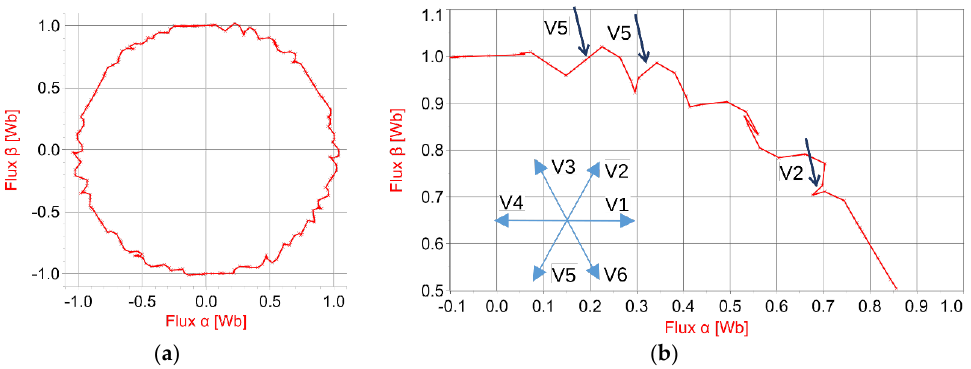
Figure 12. ( a ) The measured flux vector tip trajectory in αβ plane in one flux vector turn at the model predictive control (MPC) strategy; ( b ) The detail of the trajectory in sector